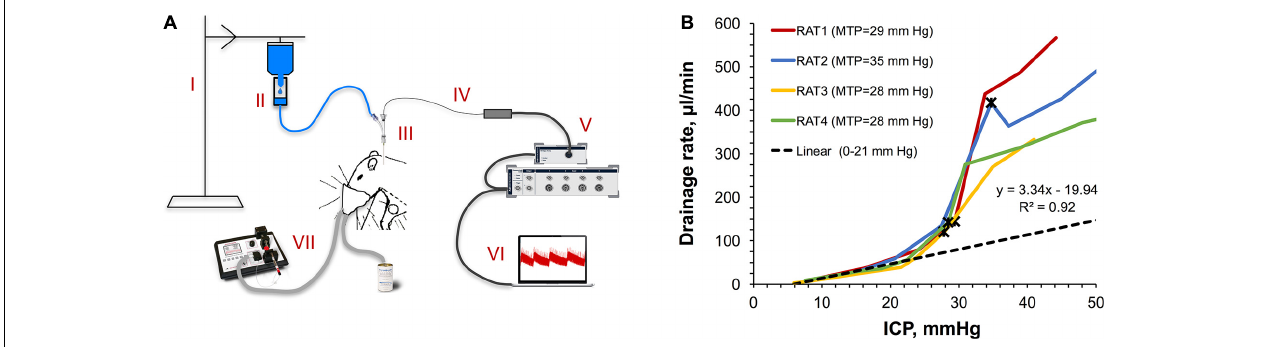
FIGURE 2 | Viability of the CSF drainage system under pressure. (A) A sketch of the originally developed experimental setup for measuring the rate of unconstrained CSF drainage at different ICPs. Components of the setup: (I) bench-top pole with a suspended saline bag set at different heights, (II) dripper with calibrated drop size attached to the saline bag and connected to the saline line, (III) Tuohy Borst adapter attached to the catheter inserted in the cisterna magna; saline line connected to the adapter’s side arm, (IV) micro-tip pressure sensor advanced to the cisterna magna through the adapter and catheter, (V) data acquisition platform, (VI) control and data analysis console (note the ICP fluctuations on the computer screen caused by falling drops), (VII) small-animal isoflurane anesthesia platform. (B) ICP dependency of the CSF drainage rate. MTP: maximally tolerated pressure. Black asterisks mark MTP for each rat. Data points in the 6–23 mm Hg region were used to build a linear regression (parameters are